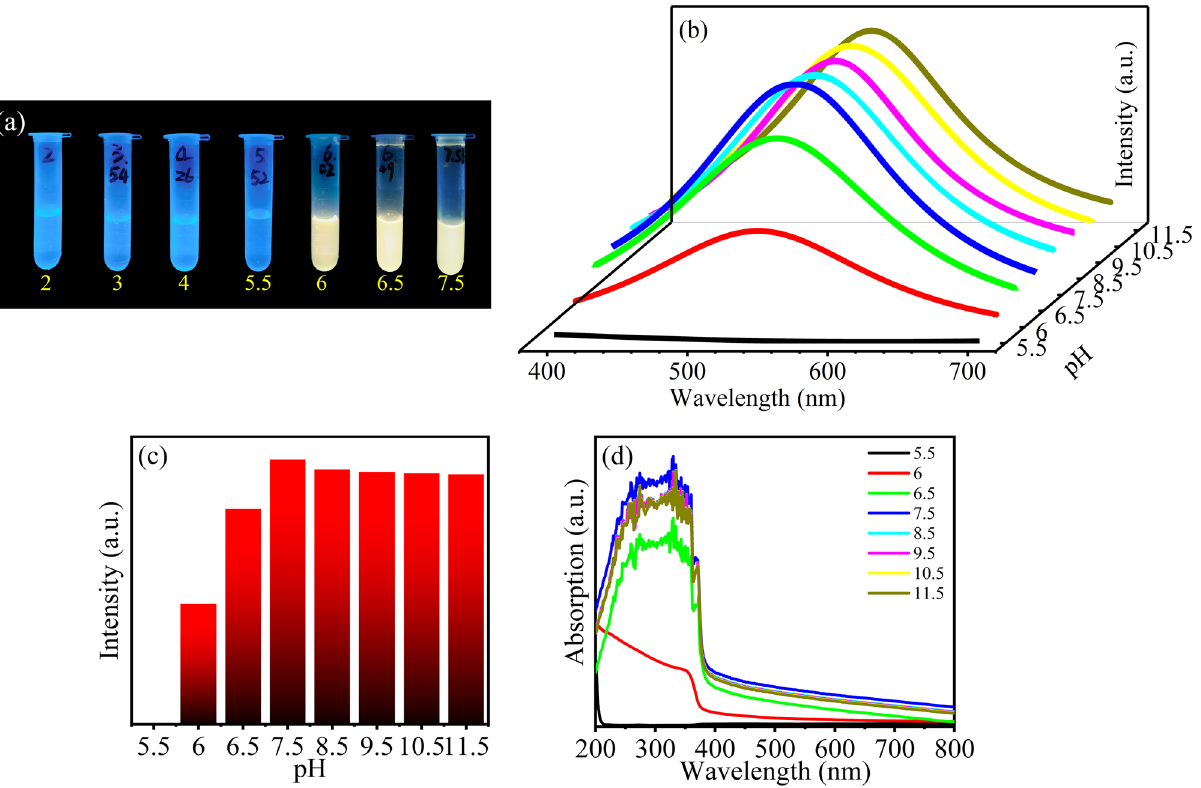
Figure 3. ( a ) The fluorescence images of M-ZnO QDs at different pH values. ( b ) The fluorescence spectra of M-ZnO QDs at different pH values. ( c ) The fluorescence peak histogram of M-ZnO QDs at different pH values. ( d ) The UV–vis spectra of M-ZnO QDs at different pH values.